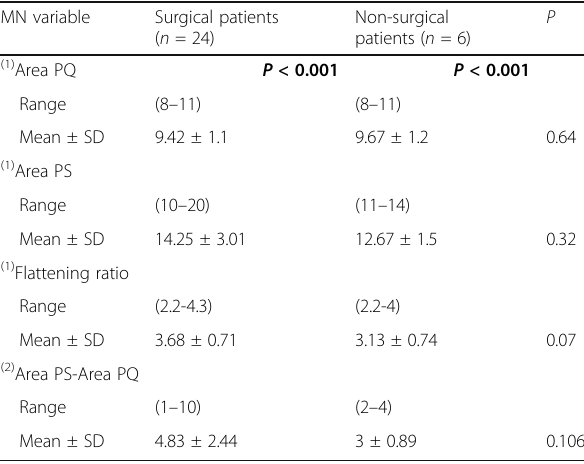
Table 2 Comparison between the MN dimensions of the surgically and non-surgically treated patients MN variable Surgical patients Non-surgical ( n = 24) patients ( n =